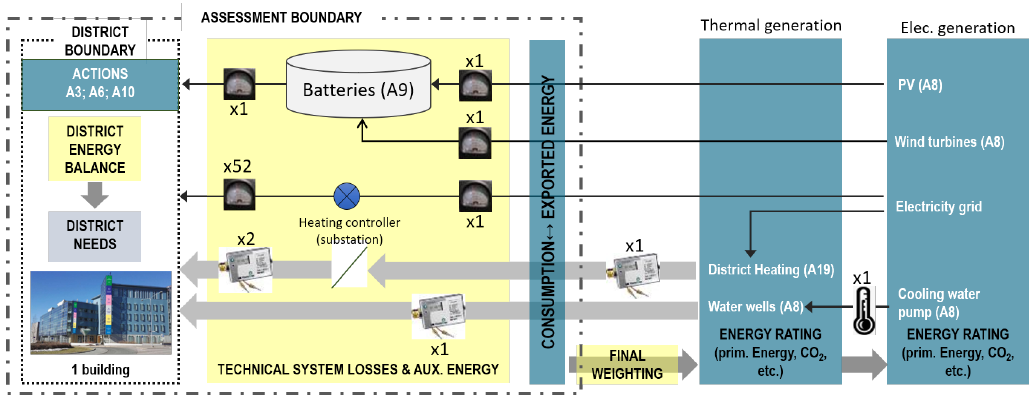
Figure 5. Monitoring example for the Viiki building in